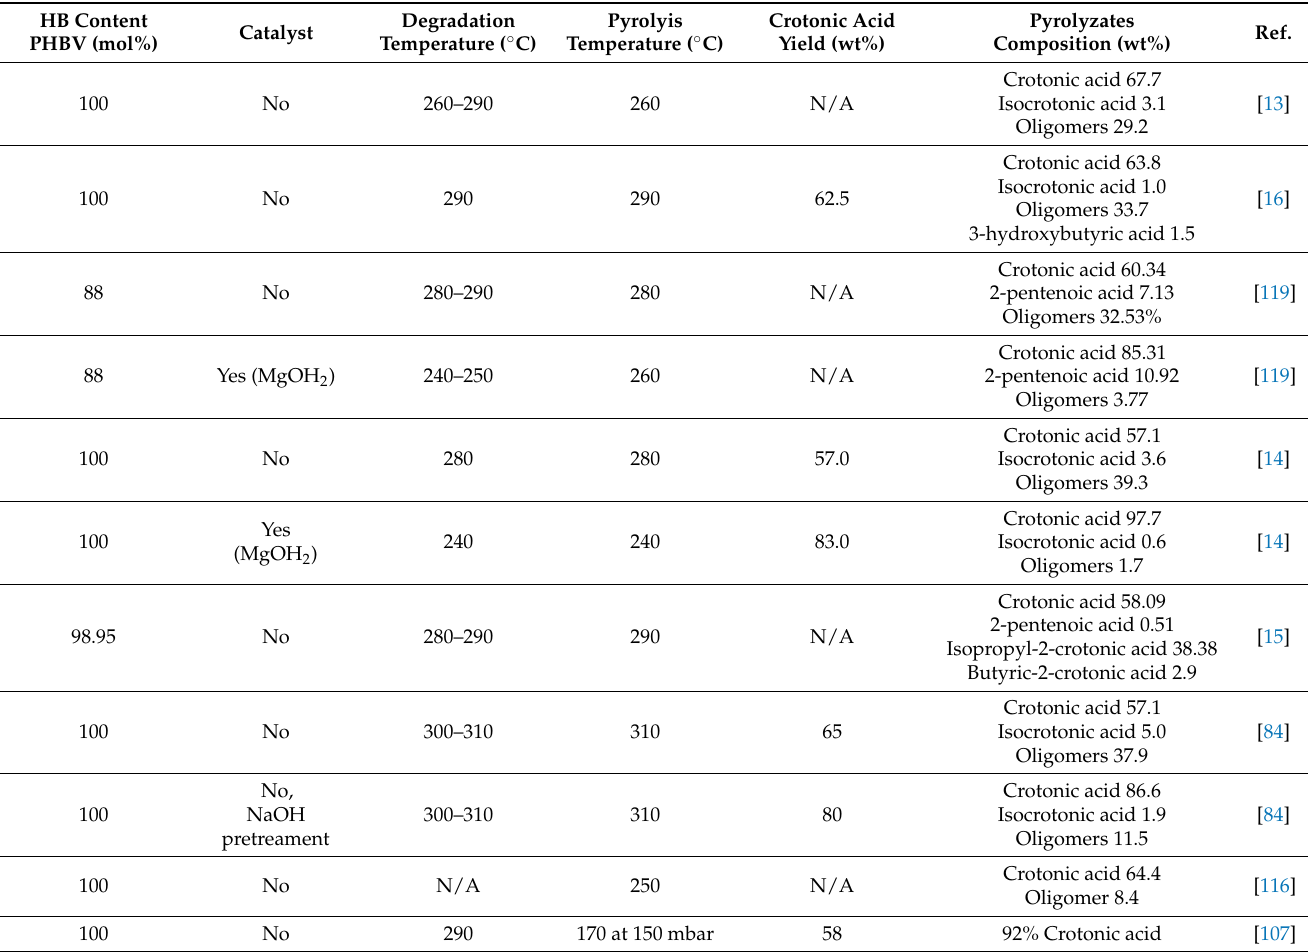
Table 3. Overview of reported pyrolysis results for PHB(V) toward crotonic